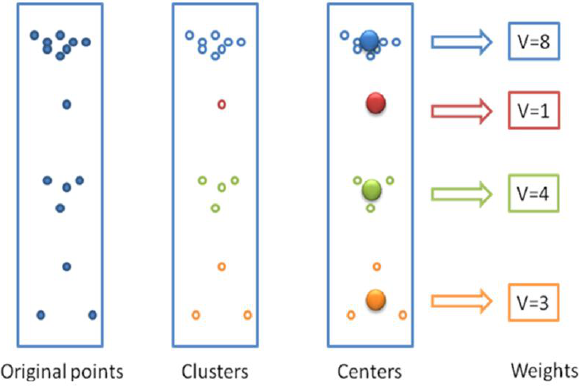
Figure 3. Process of clustering the